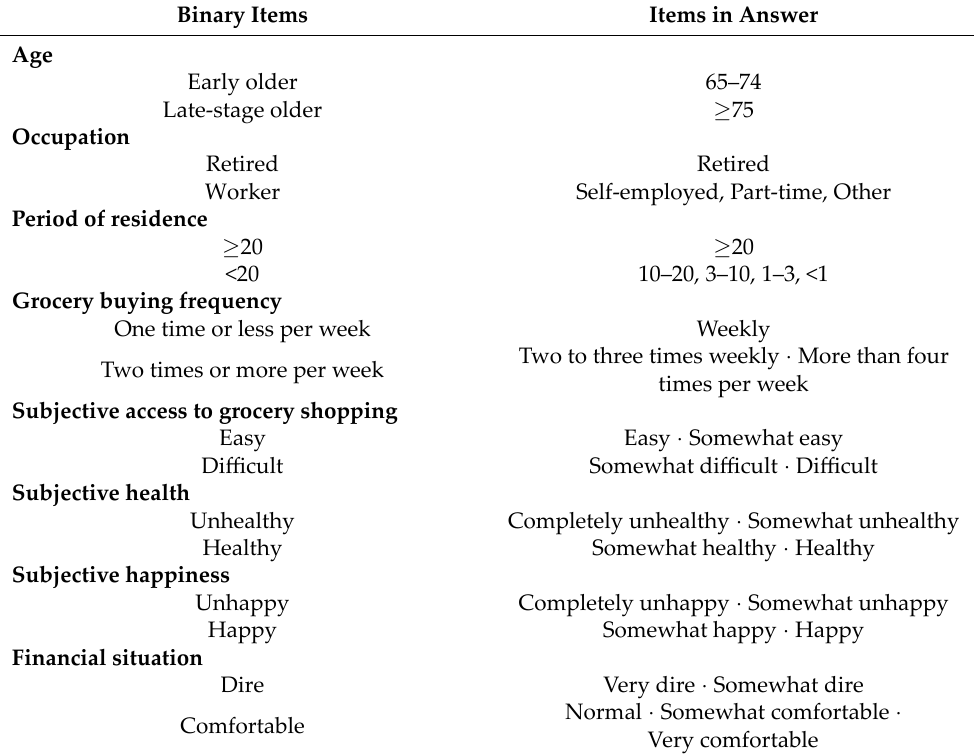
Table 1. Binary list of participant characteristics, social situation, environment, and psychological